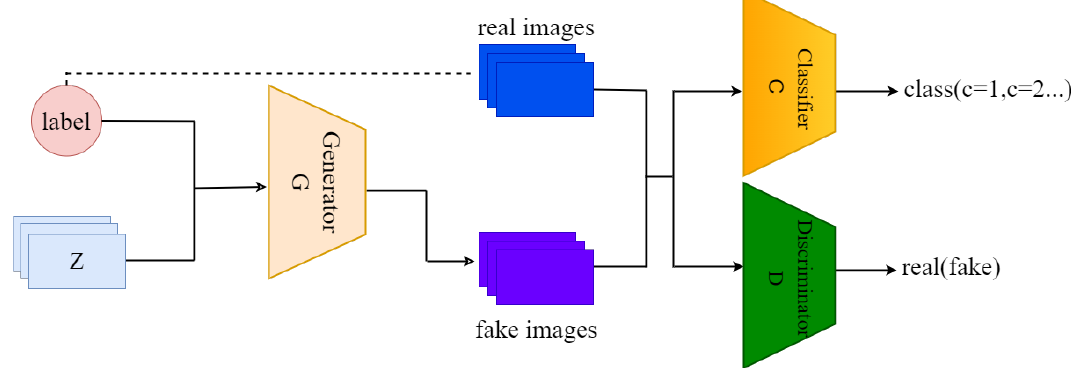
Figure 2. The image generation model framework.